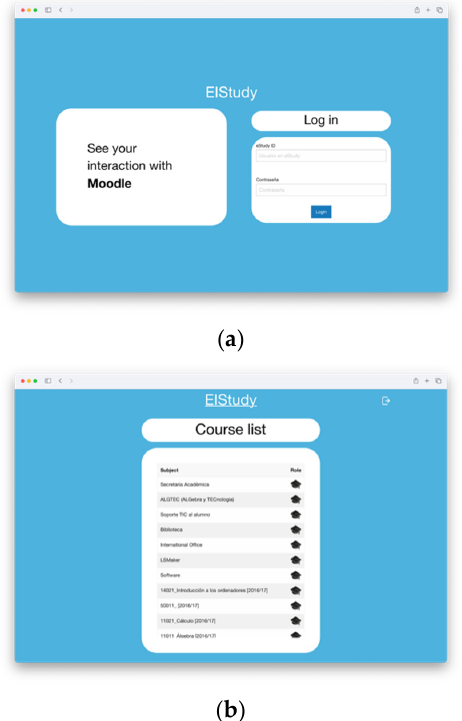
Figure 6. ( a ) EIStudy’s client login form: the user must log in using their credentials to get data related to his or her profile. If there is a failure to log in, no data will be sent to the user. If it works ( b ), it will enable the petition that sends details on the courses the user is enrolled in.